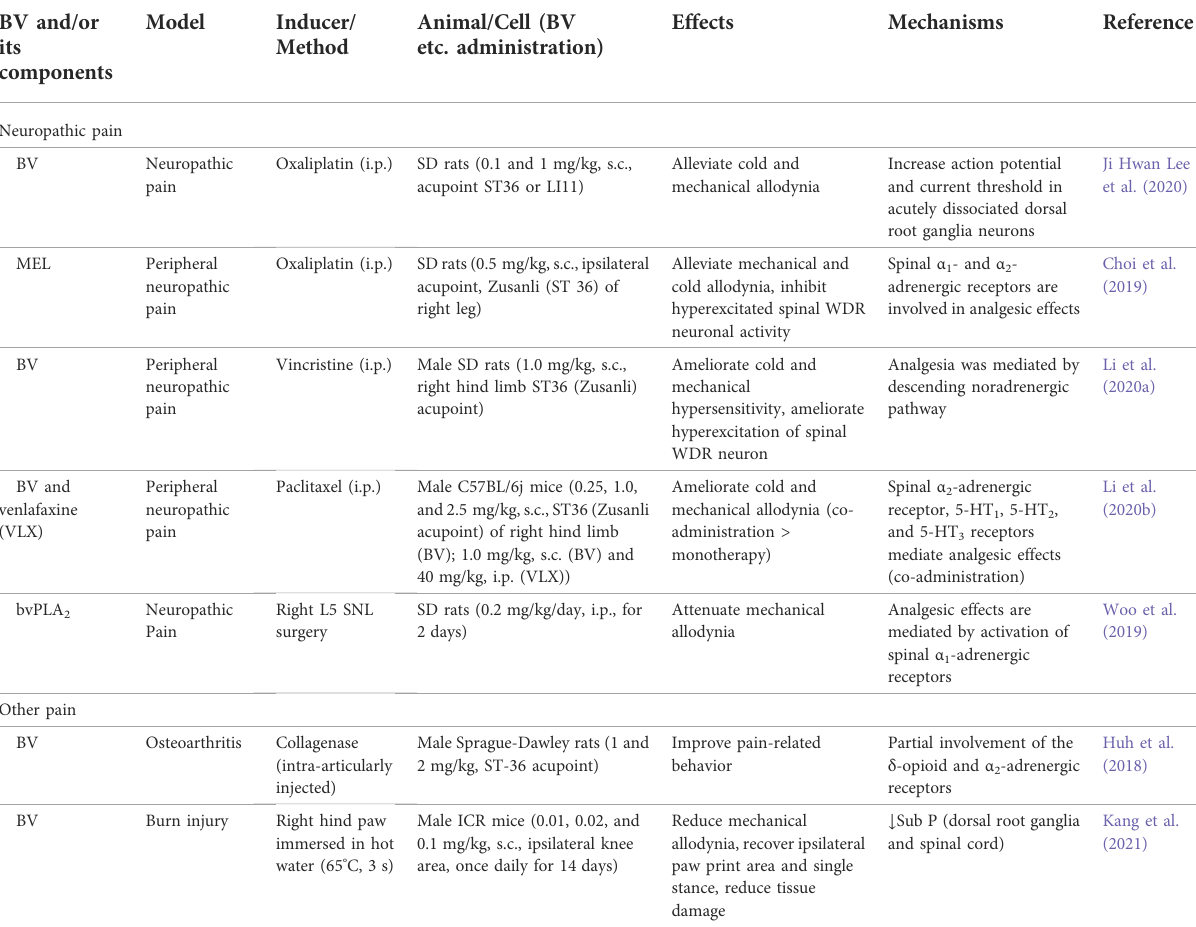
TABLE 4 Summary of the analgesic effects and mechanisms of BV and its main components. BV and/or